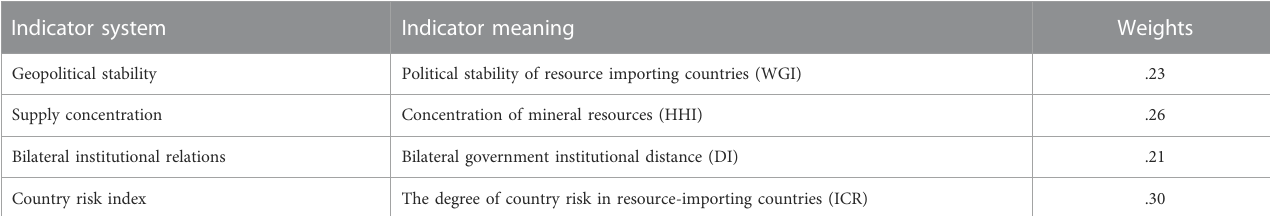
TABLE 7 Weights of indicators for lithium, cobalt, and nickel resources in China. Indicator system